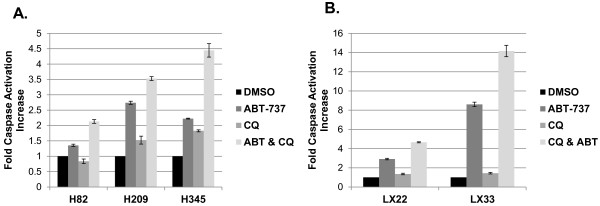
Combination of ABT-737 and chloroquine results in increased induction of apoptosis in SCLC cell lines. Cells were treated at the doses listed in Figure 1 for ABT-737 and chloroquine or the combination for 72 hrs, and then assayed using the Caspase-Glo 3/7 assay. Luminescence is directly proportional to the amount of caspase-3 activation. Commercially available cell lines are shown in A and cell lines derived from patient xenografts are shown in B. Error bars: SD; n = 4.